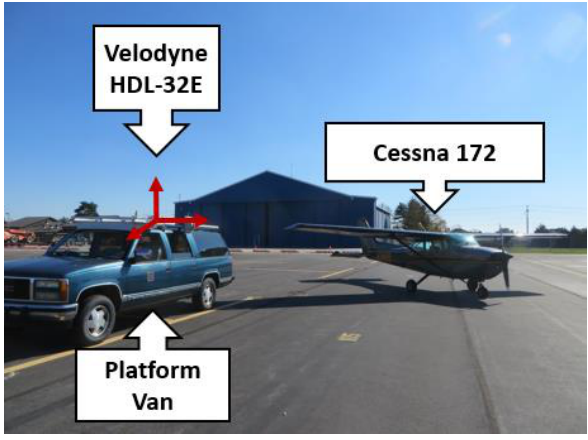
Figure 3. Test arrangement